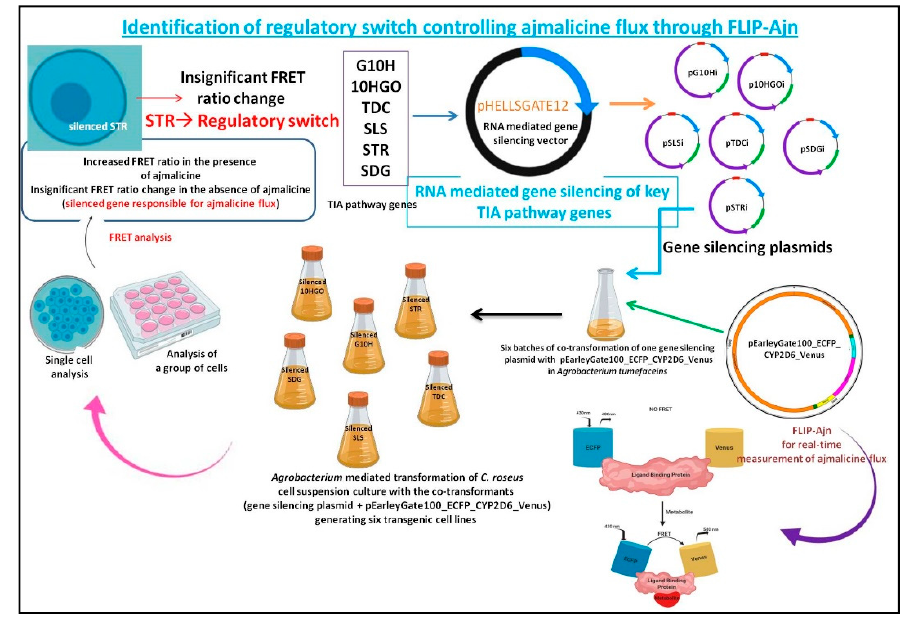
Figure 1. An overview of the methodology involved in the identification of the regulatory switch controlling ajmalicine flux through Fluorescent indicator protein for ajmalicine FLIP-Ajn.